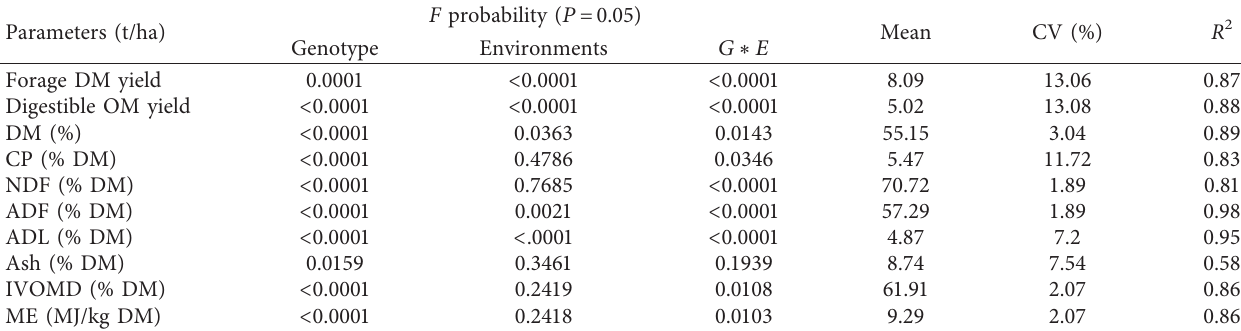
Table 1: Combined analysis of variance for herbage dry matter (DM) and digestible organic matter (OM) yield and quality parameters of the seven oat genotypes tested across six and two environments,